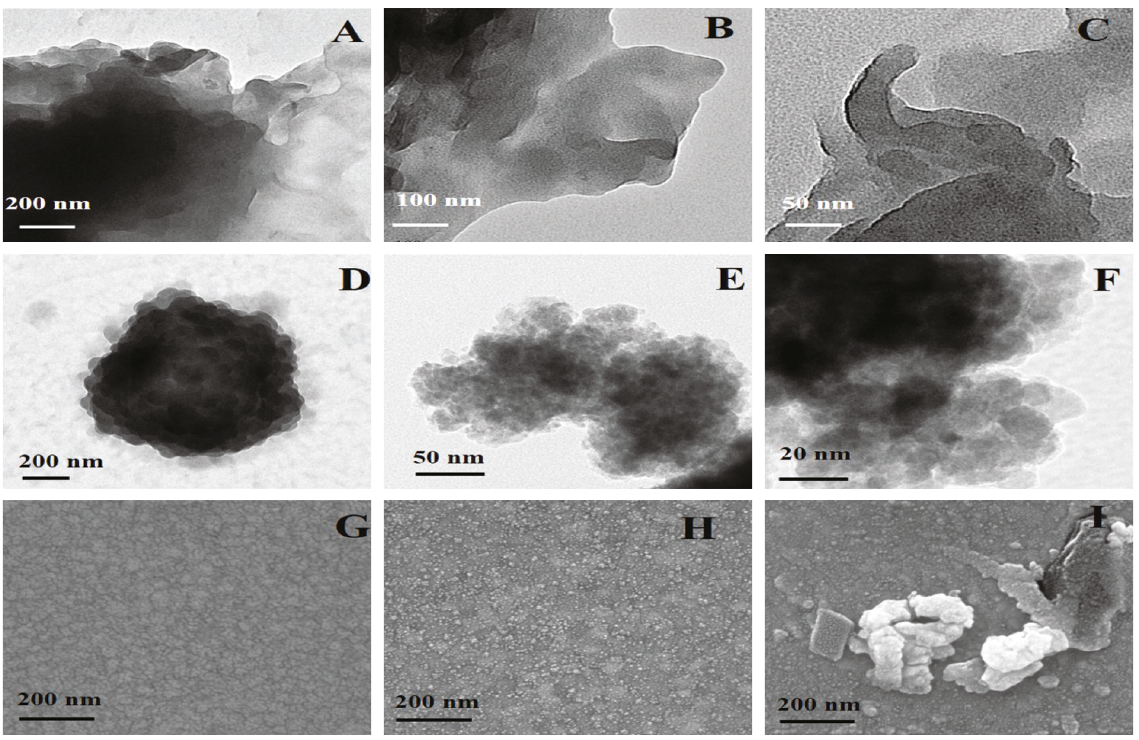
Figure 1: TEM images of COF 2+ (d–f) at different magnifications. SEM images of bare GPE TFPB-TZT (a–c) and COF TFPB-TZT /Hg (g), GPE/COF TFPB-TZT (h), and GPE/COF TFPB-TZT /Hg 2+ (i). H 2 N